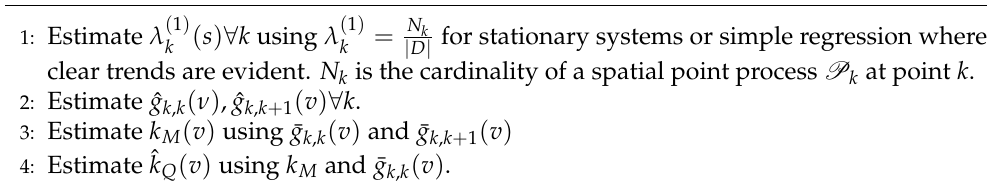
Algorithm 3 Analysis for dynamic, homogeneous, isotropic spatiotemporal point